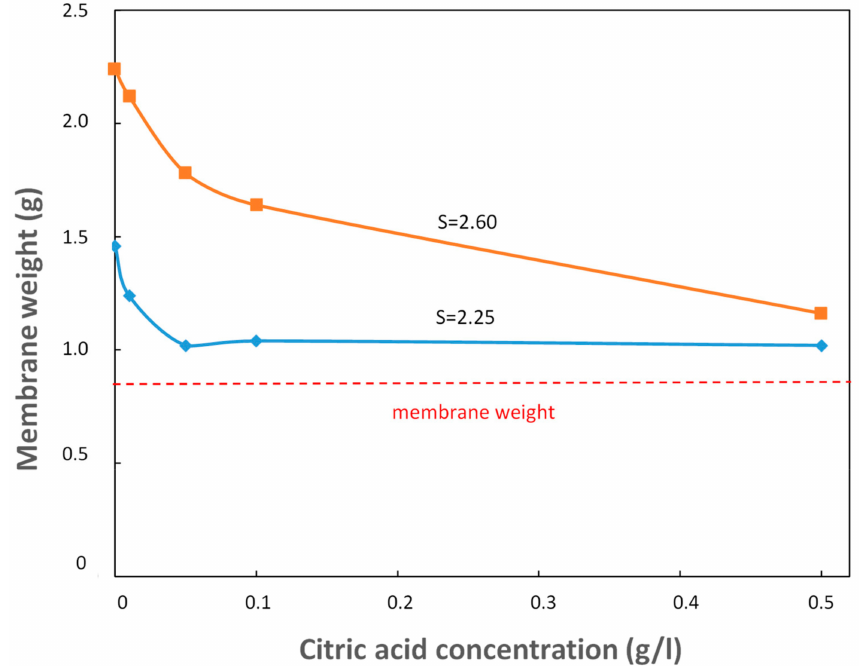
Figure 4. Membrane weight after drying as a function of citric acid for two supersaturation values. Water 2019 , 11 , x FOR PEER REVIEW